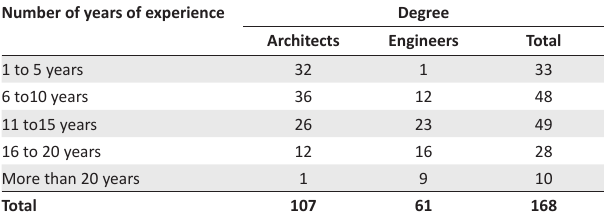
FIGURE 1: Profession region practice. (a) Architects, (b) TABLE 2: Number of years of professional experience.